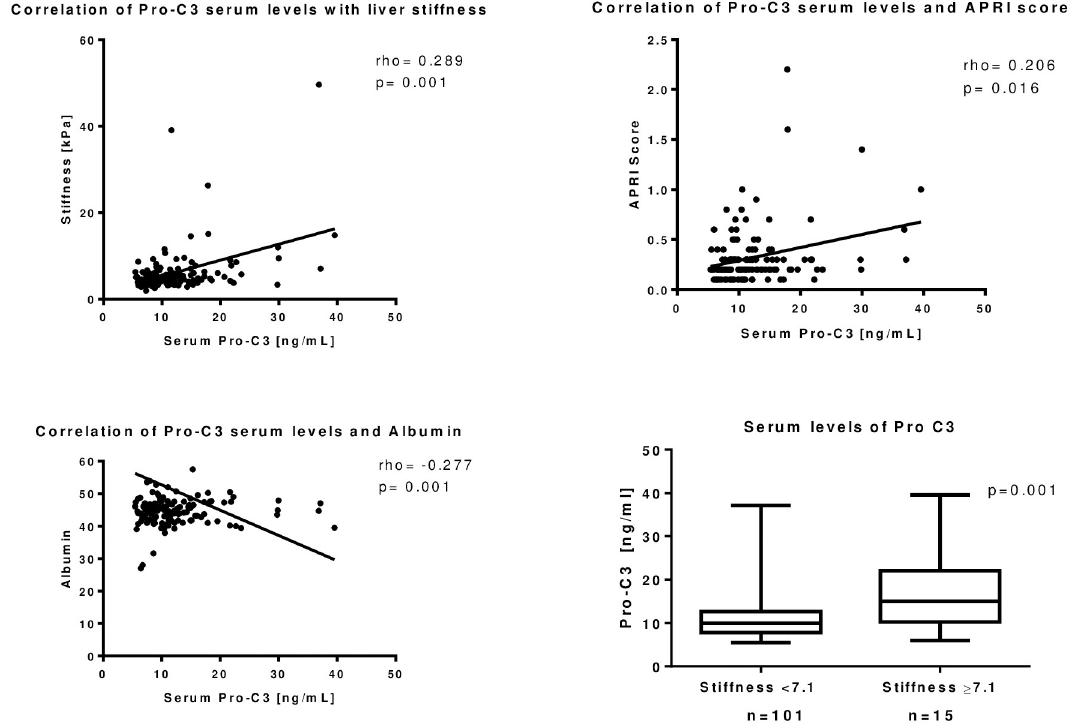
Fig 2. Levels of PRO-C3 measured in blood of patients with HIV infection correlated with liver stiffness and liver function parameters. Levels of PRO-C3 correlated with liver stiffness measured by A) Fibroscan (rho = 0.289; p = 0.001) and B) APRI score (rho = 0.206; p = 0.016) and inversely with C) albumin (rho = -0.277; p = 0.001). Furthermore, D) significant higher levels of PRO-C3 could be detected in patients with relevant fibrosis versus patients without fibrosis (p = 0.001).